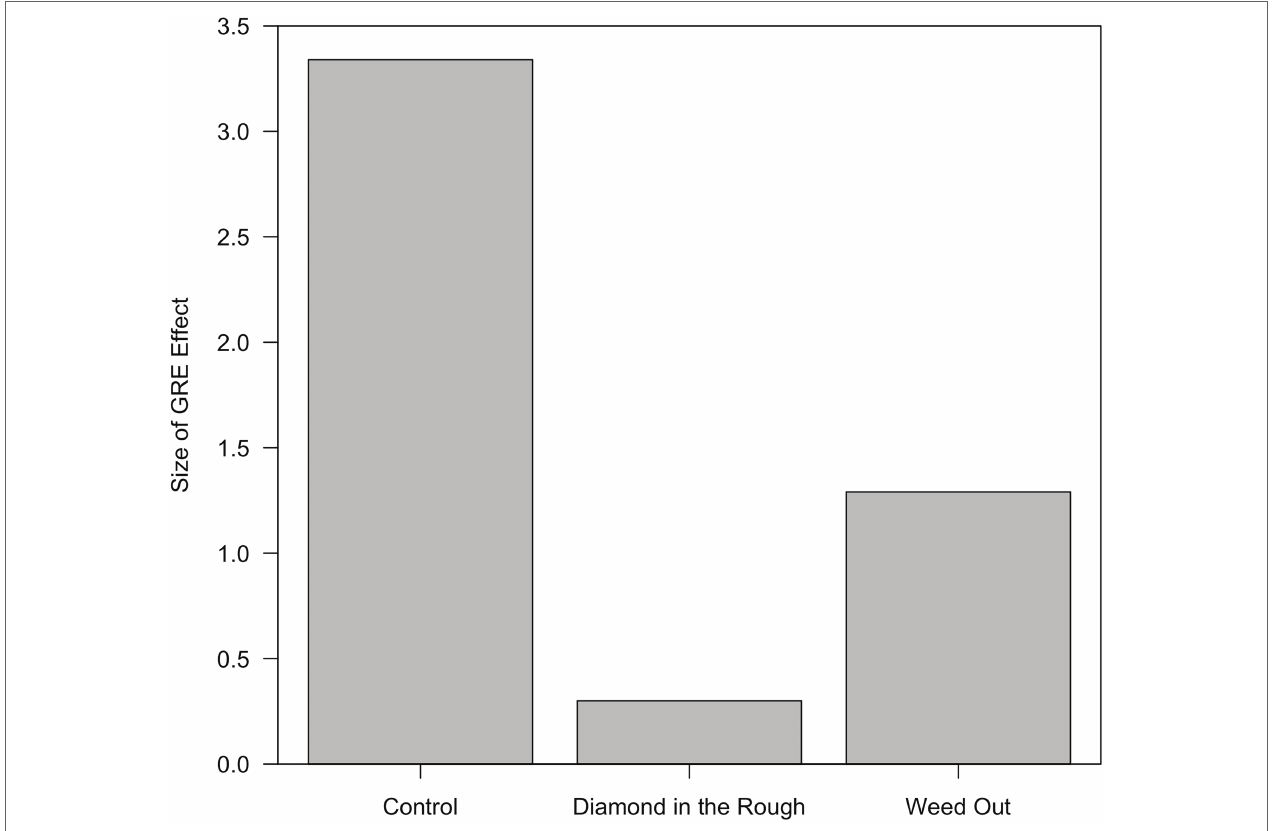
FIGURE 2 | The difference between the mean competence scores in the high GRE and average GRE vignettes as a function of instructional